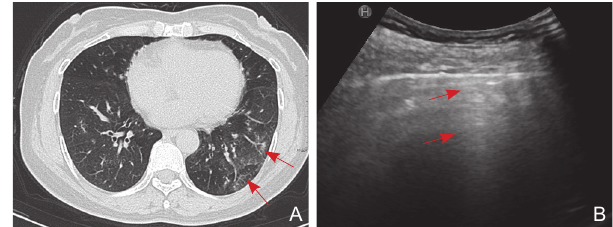
A B Figure 3 This 58-year-old female had sore throat for 6 days and fever for 3 days, and she had close contact with COVID-19 pneumonia patient. (A) Chest CT shows multiple patchy GGO (arrows) in the left peripheral lung. Lung US in the corresponding location reveals suspected B lines (arrows).